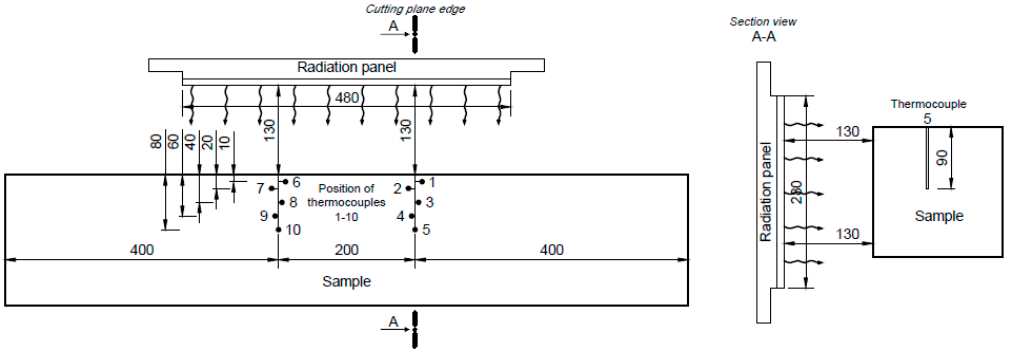
Figure 2. The experimental setup showing the position of thermocouples used.